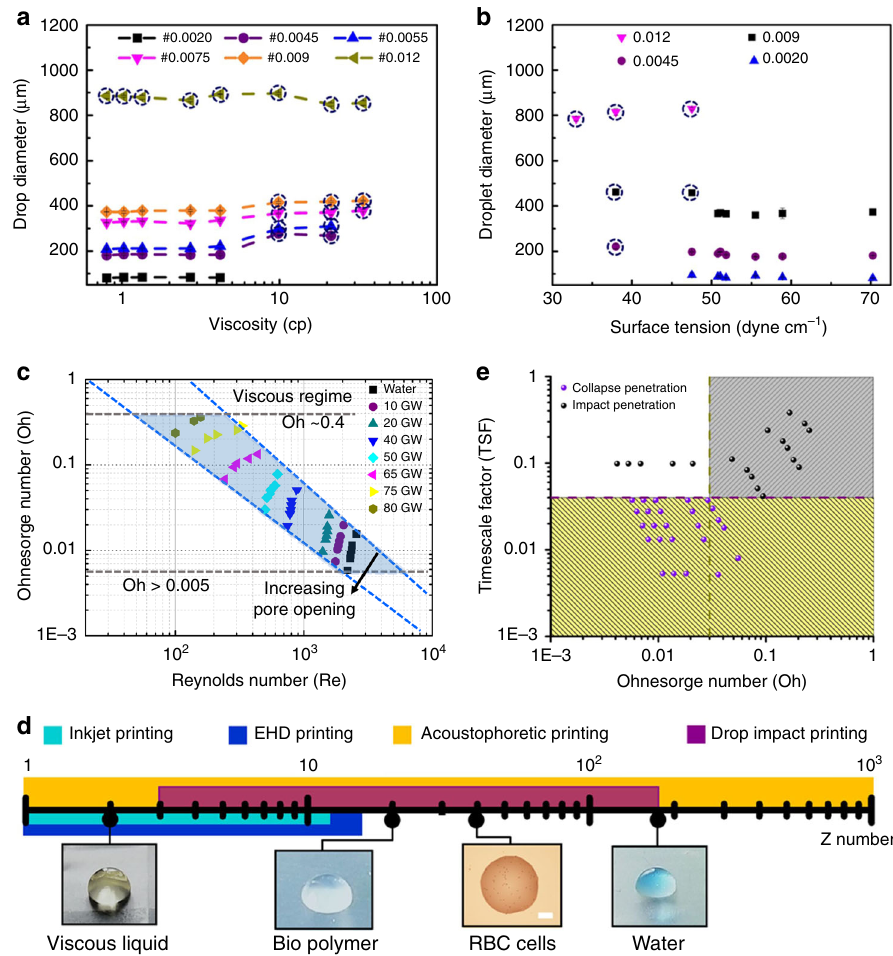
Fig. 2 Parametric studies showing the capabilities of drop-impact printing technique. The extent of viscous liquid and low surface tension liquid printing was explored using glycerol water solution, polyethylene glycol (PEG) water solution, and ethanol-water solution. The ejected droplet diameter was plotted with ( a ) liquid viscosity and ( b ) liquid surface tension for a sieve with different pore openings. c The printable regime was observed in the plot between Ohnesorge and Reynolds number. The light-blue shaded part shows the printable region of drop-impact printing technique. The range gives us an idea of the extent of different liquids that can be used for printing. d The broad range of liquids is shown in terms of Z number with inset images showing the different liquid drops that can be printed. The drop-impact printing technique (shown with purple color bar) was compared to inkjet printing, electrohydrodynamic (EHD) printing and acoustophoretic printing represented with turquoise, blue, and yellow bars, respectively (scale bar: 100 µ m). e The mechanism of different ejection modes was explained based on a timescale factor with varying Ohnesorge number. The critical Ohnesorge number that ensures transition from the inertial to viscous regime was 0.03, and the time- scale factor value that de fi nes the transition from collapse-penetration mode (CPM) to impact-penetration mode (IPM) was found to be